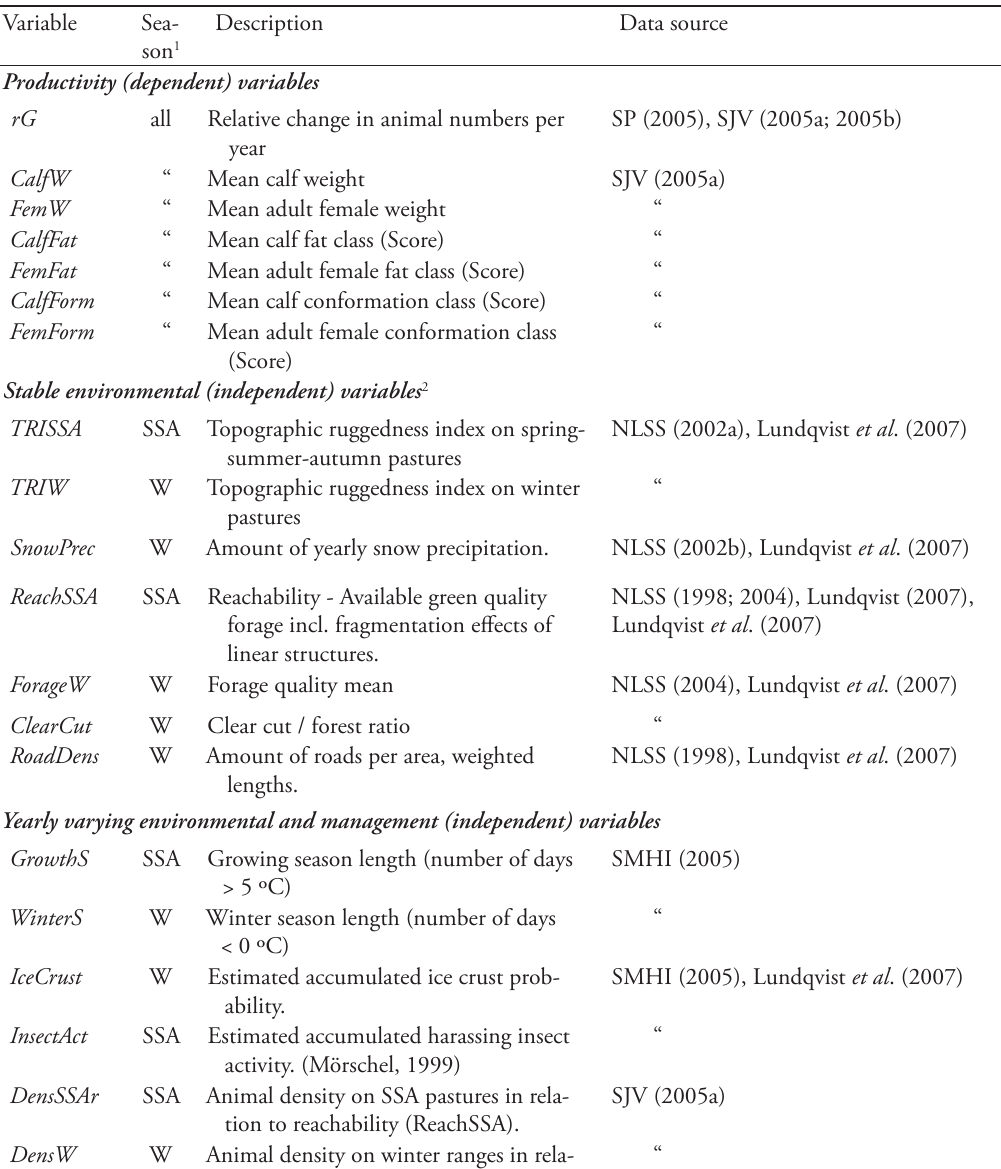
Table 1. Description of